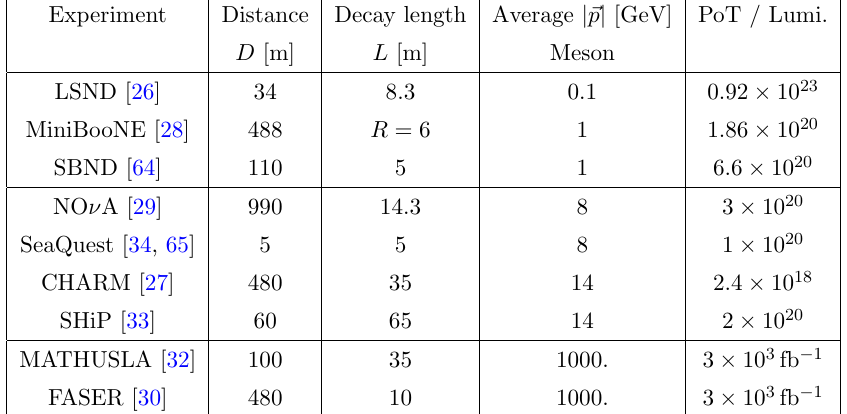
Table 6 . Experimental data for various relevant high-intensity frontier experiment. Note that MiniBooNE is a spherical detector of radius R (cid:24) 6m. For standard beam-dump experiments, the average boost factor has been determined from direct simulations using a modi(cid:12)ed BdNMC [61{ 63] from a dark photon mediator. For LHC-based experiments, we used ref. [66] for FASER and MATHUSLA. Energy quantities are in GeV while distances are in